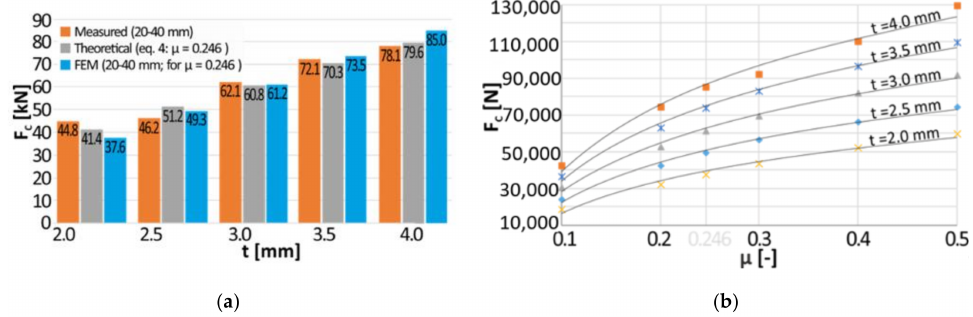
Figure 10. The results of the simulation of expanding tubes: ( a ) E / m = f(d); ( b ) F C / m =